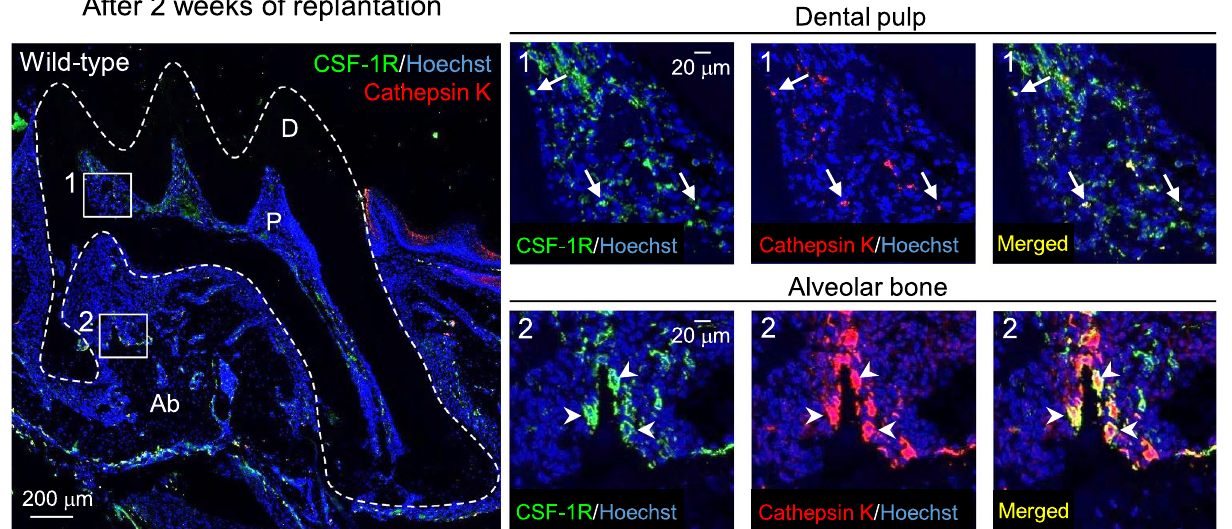
Figure 3. OPG negatively regulates traumatic damage-induced odontoclast differentiation in the dental pulp. ( A – C ) Representative images of 8-week-old mice replanted maxillary first molars from wild-type ( B , upper panels) and OPG-KO ( A and B , lower panels) stained with TRAP and hematoxylin. Right panels are magnified views of boxed areas. Asterisks: dentin tissue without odontoblast layer and predentin, black arrows: mono- nucleated TRAP + odontoclast-like cells, black arrowheads: multi-nucleated TRAP + odontoclast-like cells. Quantification of the number of TRAP + odontoclast-like cells in the whole pulp tissue of undamaged and replanted maxillary first molars ( C ). * p < 0.05. Data are represented as mean ± SD; 8-week-old mice; n = 4. ( D ) Representative z-stack confocal images of replanted maxillary first molars from 8-week-old wild-type mice stained with anti-CSF-1R and anti-cathepsin K antibodies. White arrows: CSF-1R + Cathepsin K + odontoclast- like cells, white arrowheads: CSF-1R + Cathepsin K + osteoclasts. Nuclei were stained using Hoechst. Numbered panels are magnified views of boxed areas. n = 3. P: pulp, D: dentin, Ab: alveolar bone, ND: not